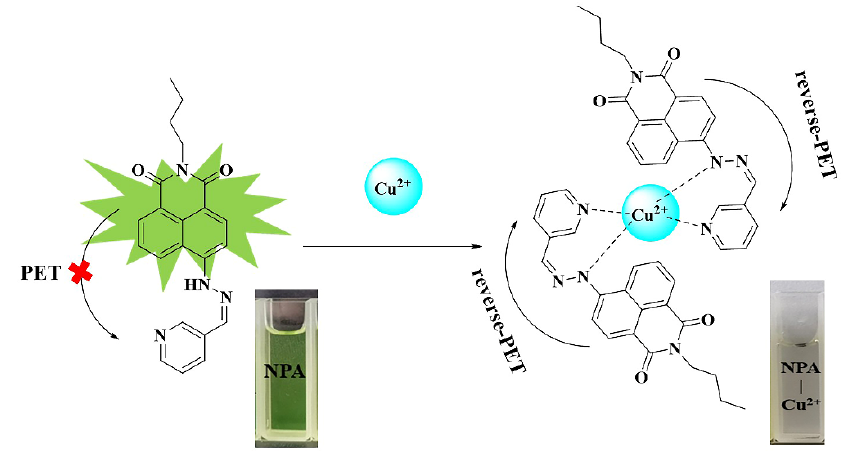
Figure 5. 1 H NMR titration plots of NPA probe with Cu 2+ in DMSO− d 6 . (a, c, d, e: naphthalimide; b, c, g, h: pyridine; f: CH−N; i: NH..